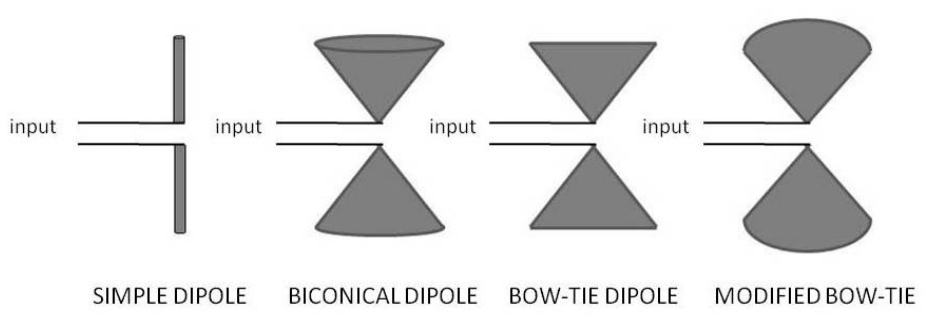
Figure 3 . Geometric evolution from simple dipole antenna to